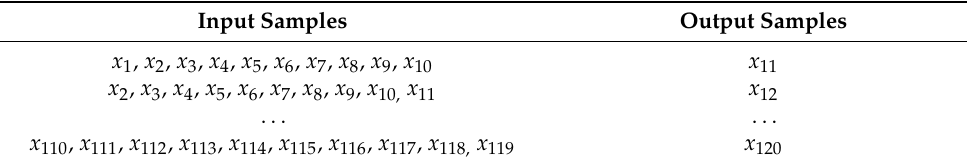
Table 6. Selection of security situation